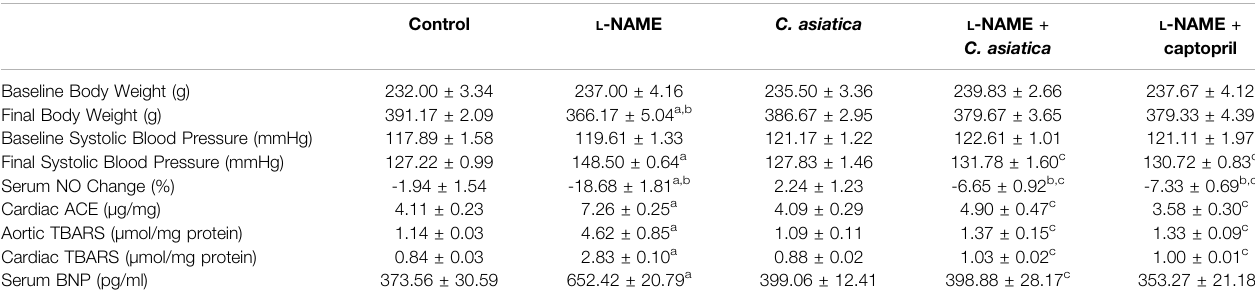
TABLE 1 | Summary of result from measured parameters. The values represent mean ± SEM ( n (cid:1)